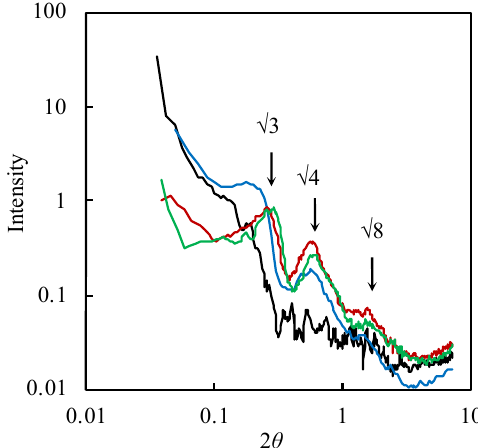
Figure 5. Small-angle X-ray scattering observation results of the MP and P formulations. Black line: MP 1.0 , blue line: MP 5.0 , red line: MP 10 , and green line: P.